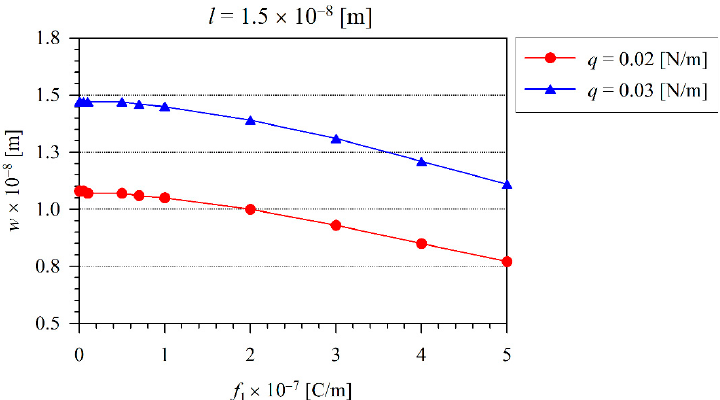
Figure 9. The variation of maximal deflection w with the flexoelectric coefficient for two different loading levels and at the microstructural length-scale parameter 8 1.5 10 m l